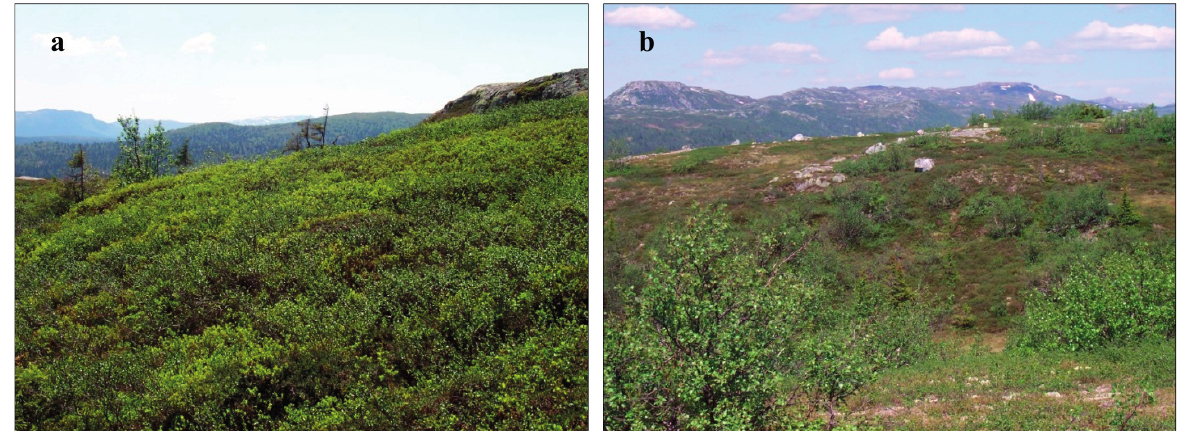
Figure 3. Photographs taken from a central part of the study area towards south ( a ) and north ( b ) showing the stage of vegetation development as observed in the field at 11:00 UTC on 10 June 2007. The ALS data were acquired at 15:20–15:55 UTC on 11 June 2007. Apart from a few wet spots with some dead grass from the previous year still visible, the ground vegetation appeared fully